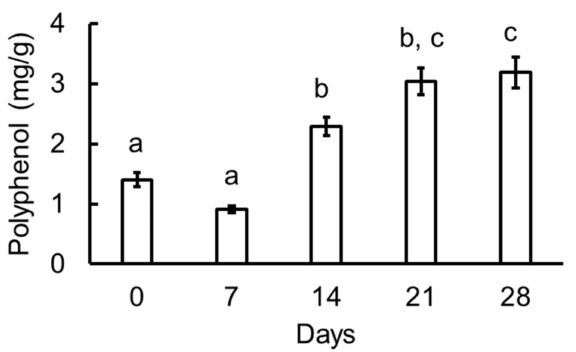
Figure 9. Total polyphenol contents in the various garlic samples. Values are mean ± SE (n = 3). Values not sharing the same character (a, b, and c) are significantly di ff erent at p <